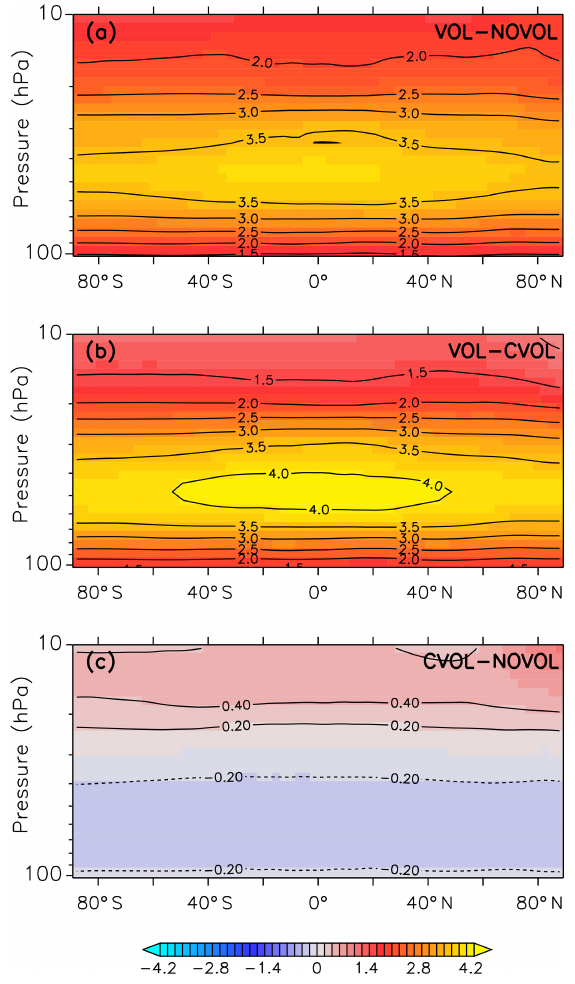
Figure 5. Monthly mean of the zonally averaged stratospheric tem- perature difference (K) between the model simulations (CVOL and NOVOL) for December 1991. Panel (a) shows the combined ef- fect, (b) the heating effect, and (c) the chemical effect. Black con- tours indicate the isothermal curves (K). Contour intervals are 0.5K in (a, b) , and 0.2K in (c) .